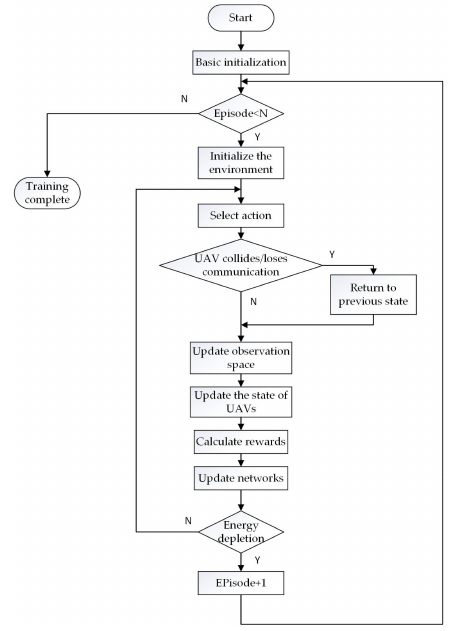
Figure 4. Explanation of the flow of our